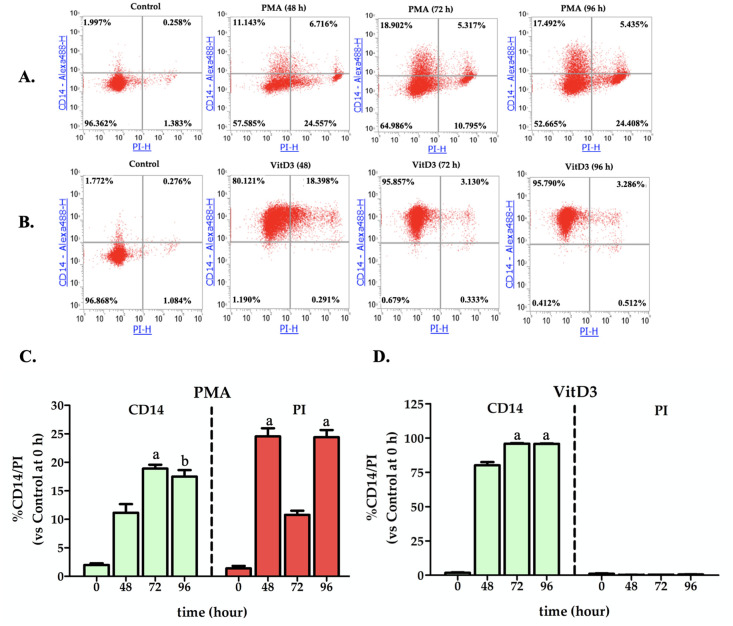
Flow cytometry analysis of CD14 expression and PI staining.Panels (A) and (B) show representative experiments of flow cytometry dot plots for PMA- and VitD3- differentiated cells, respectively. The bar graphs show analyses of CD14 expression and PI staining for PMA- (C) and VitD3-differentiated (D) THP-1 cells, measured by flow-cytometry at different time points, namely 0, 48, 72 and 96 h. The percentages of CD14- and PI- stained cells in comparison to the un-stimulated THP-1 cells (time 0) are shown. The bars show the mean ± SD of three independent duplicated experiments (n = 6); a = (P < 0.001) and b = (P < 0.01) indicate significant differences, relative to the control (0 time). Note that for PMA treated cells, the medium containing PMA was removed after 72 h to fresh media in order to get rid of PMA.